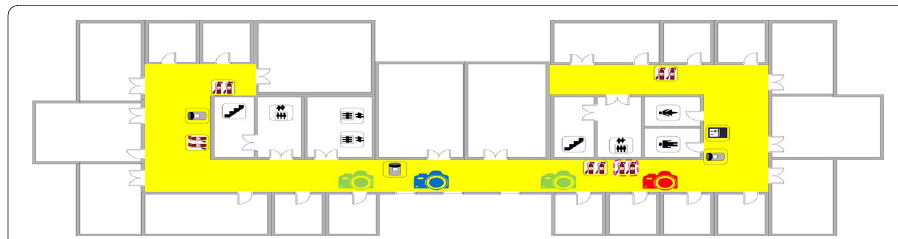
Fig. 1 Visual fingerprint displacement detection initiated by crowdsourced localization